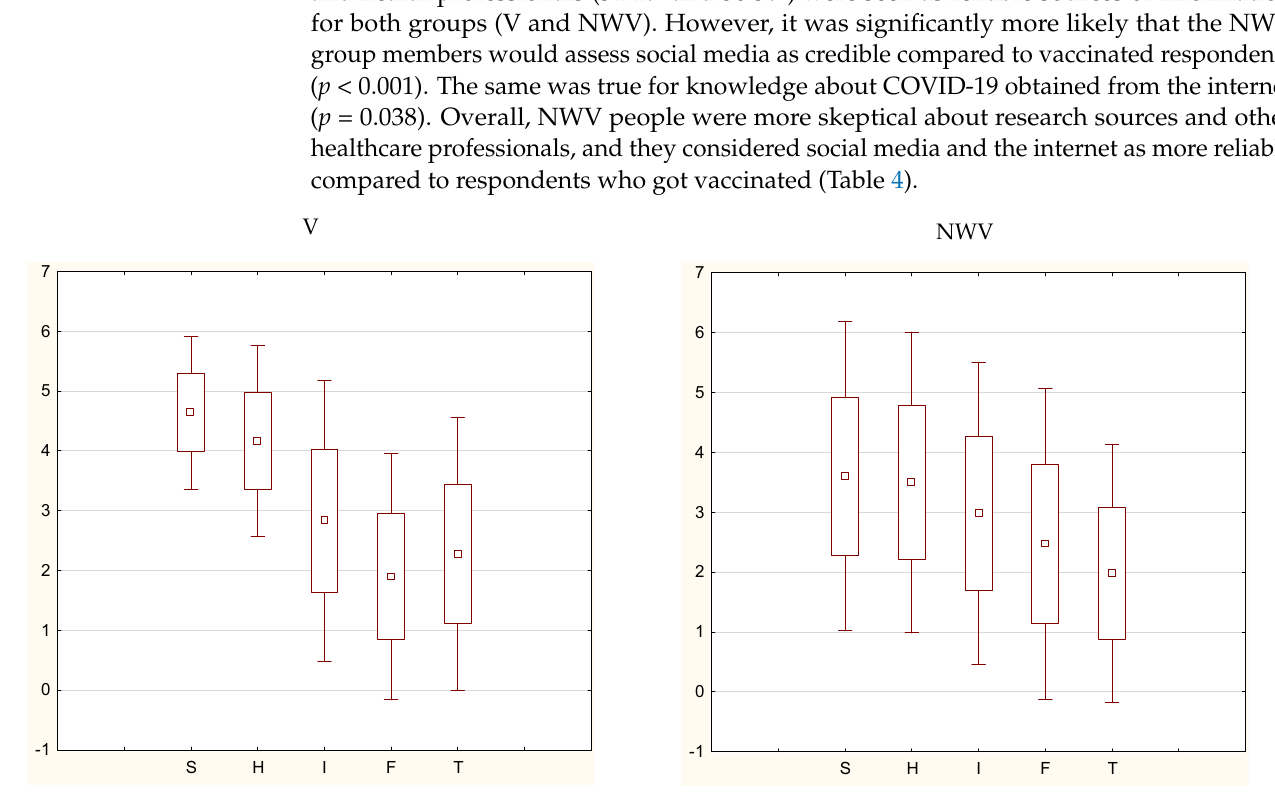
Figure 1. Reliability of individual information sources. Reliability of information sources: S—scientific source (academic lectures, medical literature, conferences, other courses), H—health professionals, I—internet sites dedicated to COVID-19, F—friends and social media, T—traditional media (radio, television, press); V—vaccinated, NWV—not wanting to vaccinate (mean, standard deviation, 1.96 × standard deviation). Table 4. Reliability evaluation of given sources of vaccination knowledge. Reliable Not Reliable